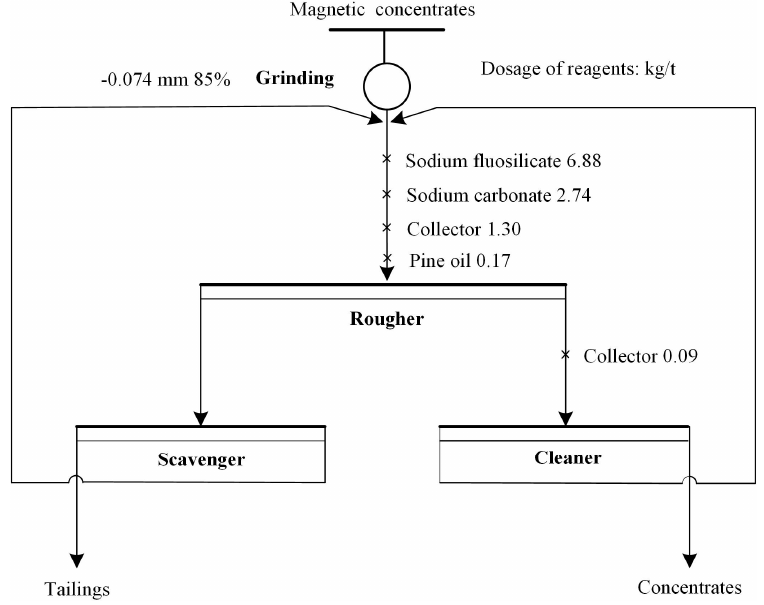
Figure 2. The flow sheet of industrial flotation in the Baotou iron Mine.